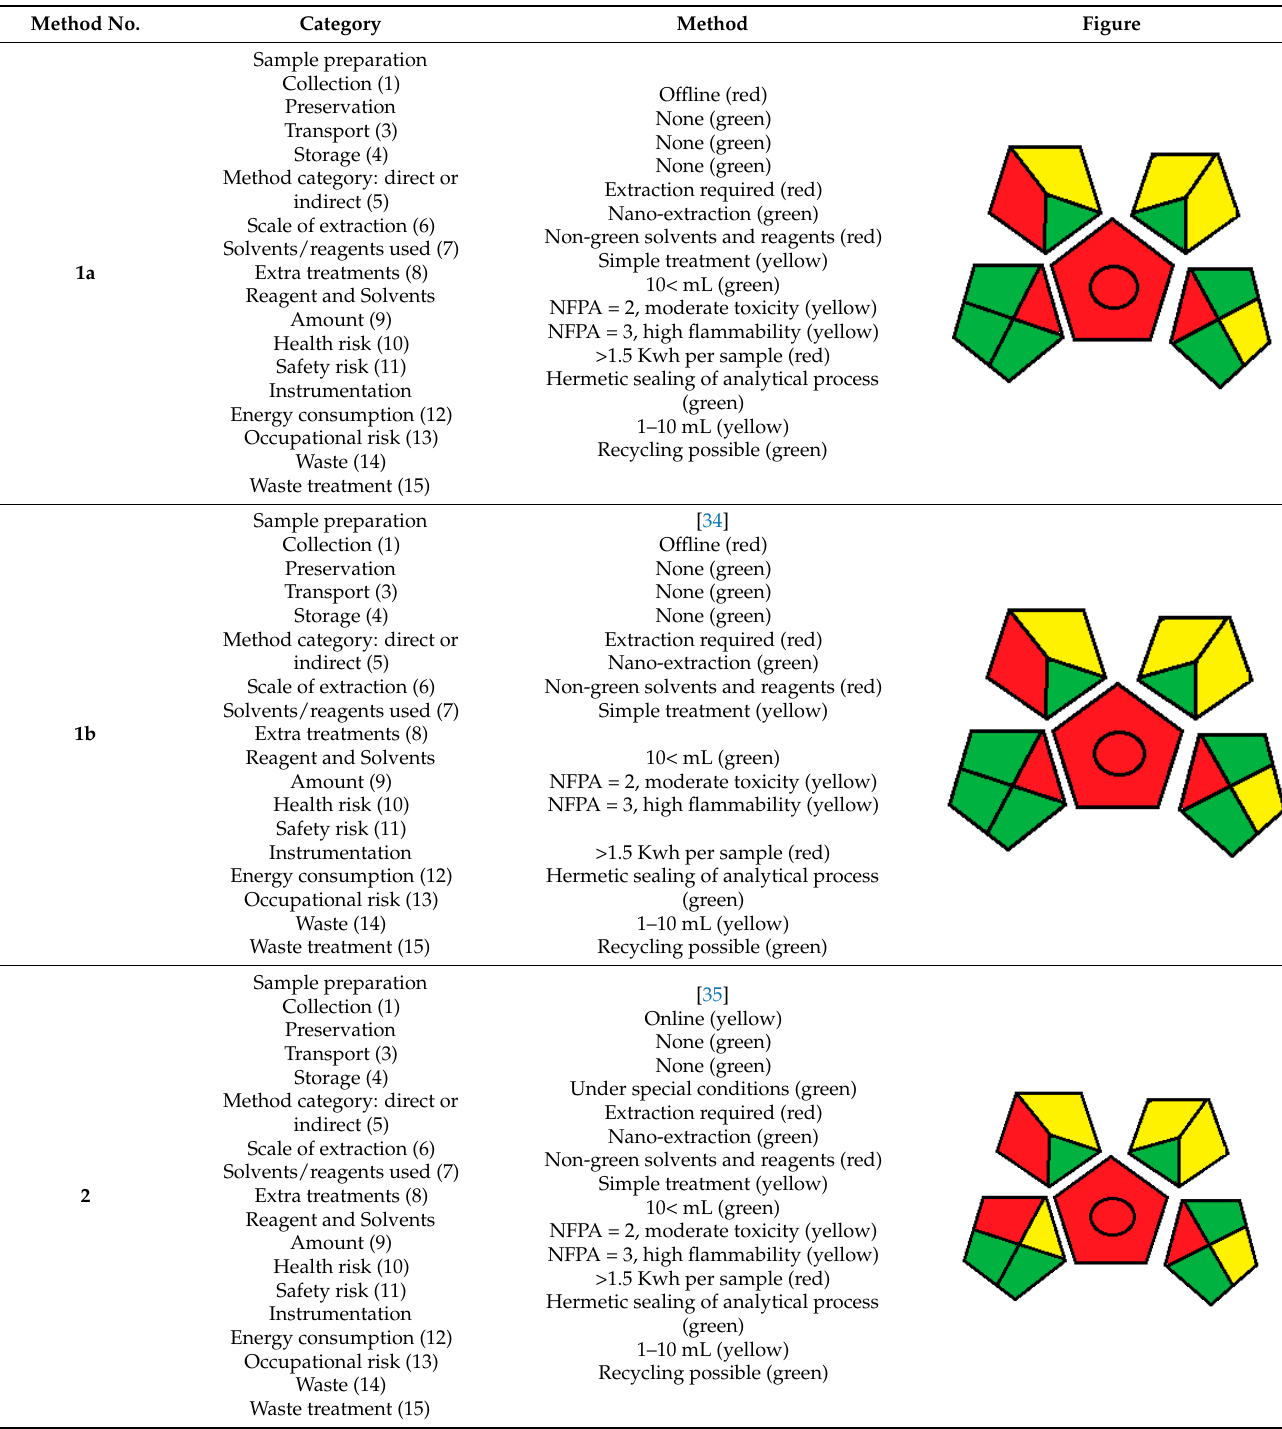
Figure Method Category